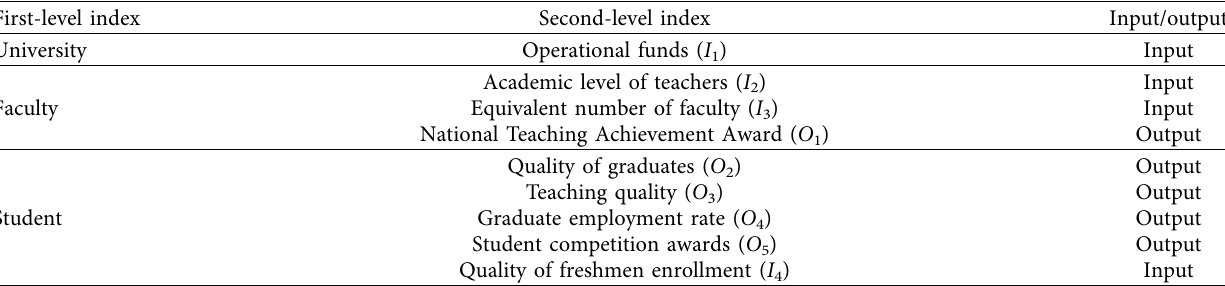
Table 2: The teaching efficiency evaluation index system for “Double First-Class” universities in